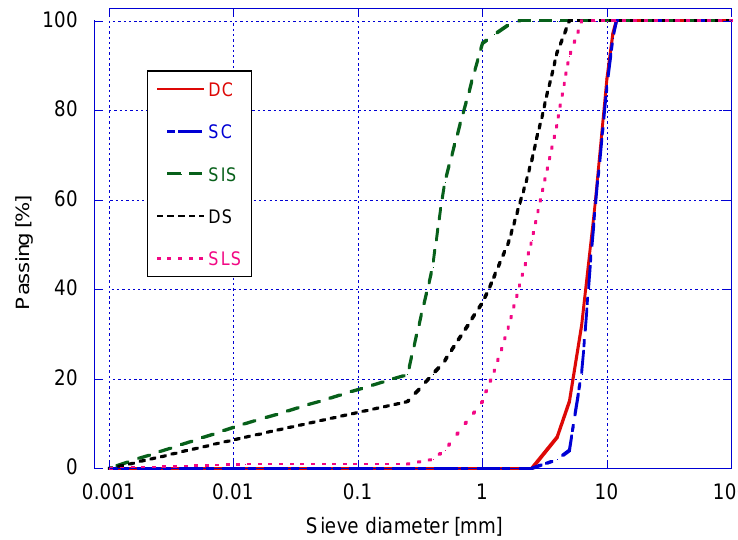
Figure 1. Aggregates granulometric grading.